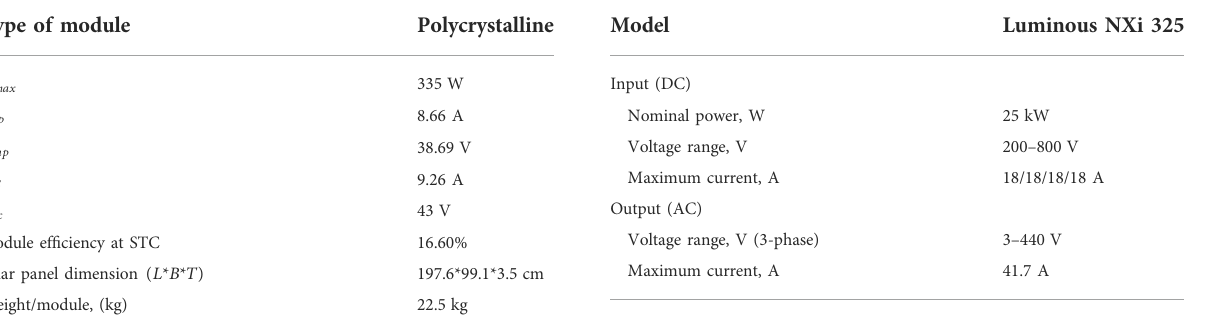
TABLE 2 PV module speci fi cations.